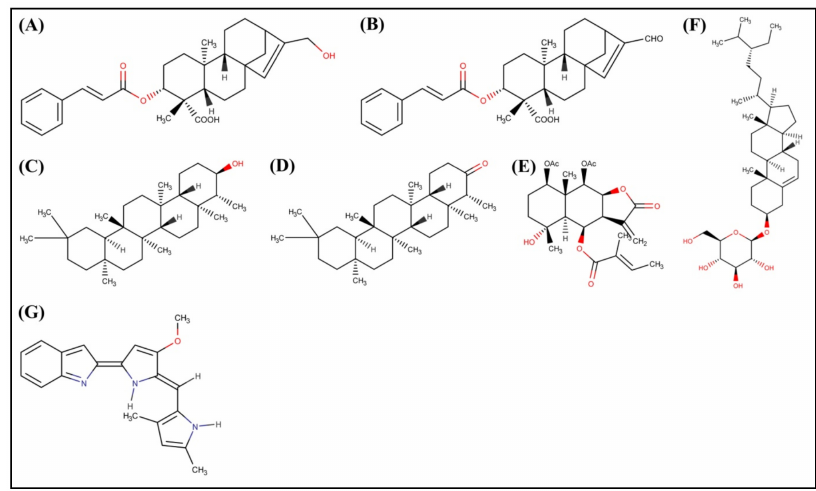
Figure 3. Chemical structure of the top potential phytochemicals from W. trilobata and standard drug. ( A ) Wedelidin A; ( B ) Wedelidin B; ( C ) Friedelinol; ( D ) Friedelin; ( E ) Trilobolide 6-O-angelate; ( F ) Daucosterol; and ( G ) Obatoclax.